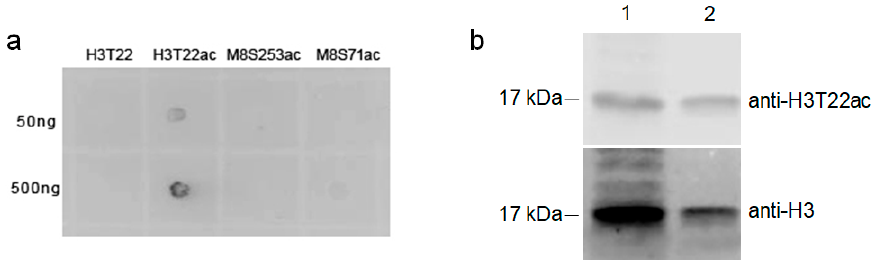
Figure 4. Validation of the acetyl-T22 in human histone H3 by immune assays. ( a ) Specificity of the anti-H3T22ac antibody was demonstrated by dot blot assay using four synthetic peptides: H3T22, un-acetylated peptide KQLATKAAR; H3T22ac, acetylated peptide KQLATacKAAR; M8S253ac, acetylated peptide KSacPLTEPNFENKC; M8S71ac, acetylated peptide TSacITPSSQDICRICHCEGDC. 50 and 500 ng of the peptides were used as indicated; ( b ) Detection of H3T22ac in human histones from different cell lysates. HEK293T (lane 1) and HeLa (lane 2) cell lysates were resolved by SDS-PAGE and detected by western blot assay using the antibodies against H3 (bottom) and H3T22ac (top).